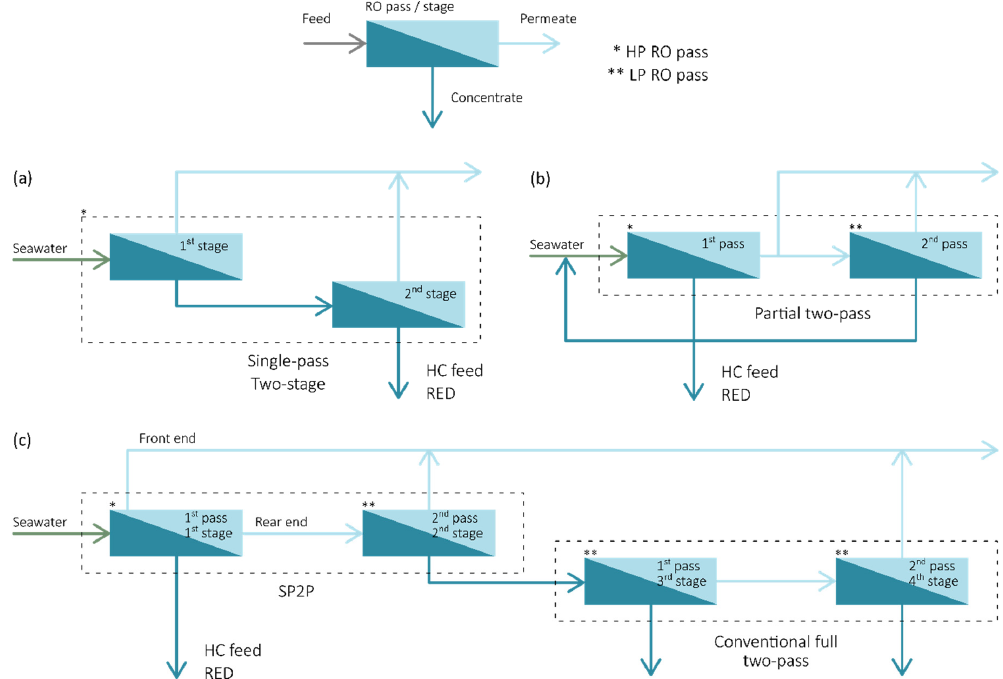
Figure A3. Overall RO configuration of some SWRO desalination plants: ( a ) Single-pass (1P) with a two-stage configuration (2S); ( b ) Generic partial two-pass (P2P); ( c ) Split partial two-pass (SP2P) with a four-stage cascade configuration (C). High pressure RO pass (HP, *); Low pressure RO pass (LP, **). The RED plant recovers energy from HP RO pass’ concentrate effluent (HC feed RED).